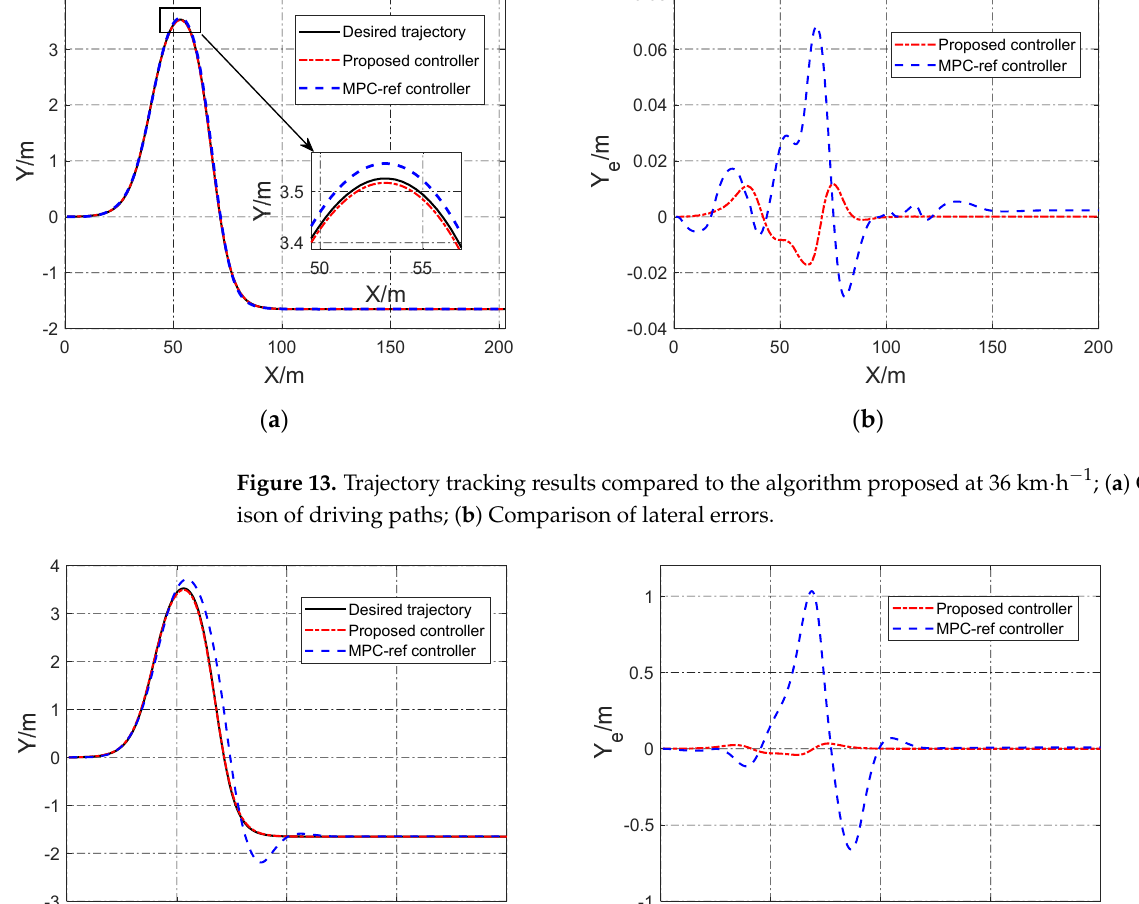
( b ) Figure 15. Trajectory tracking results at 55 km ∙ h (cid:2879)(cid:2869) .; ( a ) Driving path; ( b ) Lateral tracking error. Table 5. RESM of the trajectory tracking error. Proposed Controller